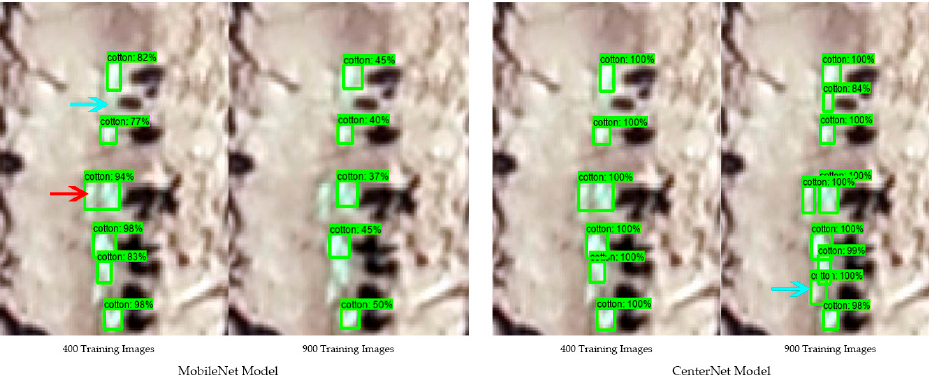
Figure 5. Examples of cotton plant detection and counting results using unmanned aerial system images having the same dimension as training images acquiring on June 8, 2020. Percentage labels around bounding boxes represent F1-scores for detected cotton plants.